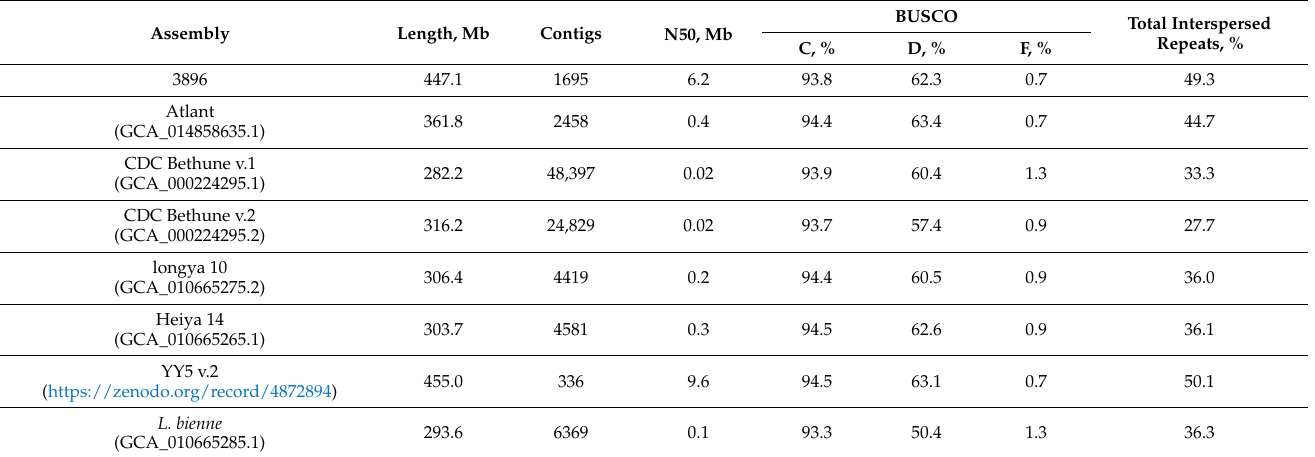
Table 3. QUAST statistics (for an assembly at the contig level), BUSCO statistics, and repeat content (for a final assembly) for the available L. usitatissimum and L. bienne genome